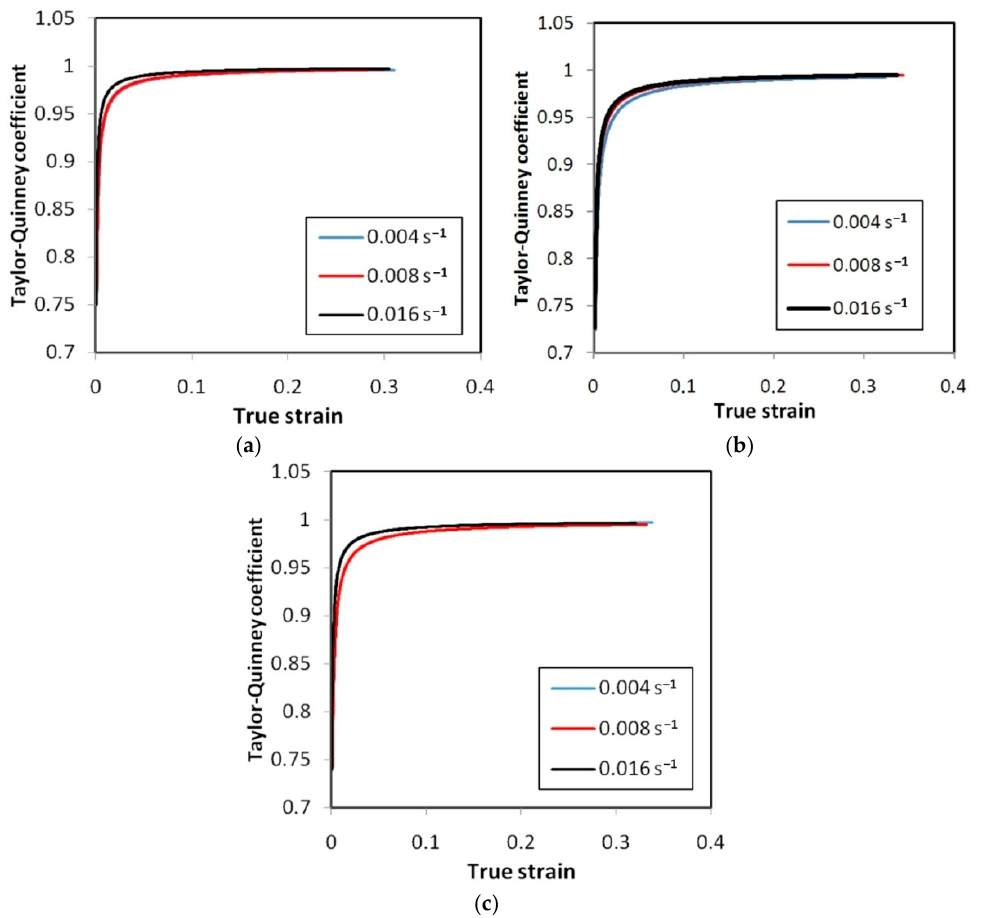
Figure 24. Variation of the Taylor–Quinney coefficient vs. true strain for I718 specimens oriented at: ( a ) 0°, ( b ) 45° and ( c ) 90°.